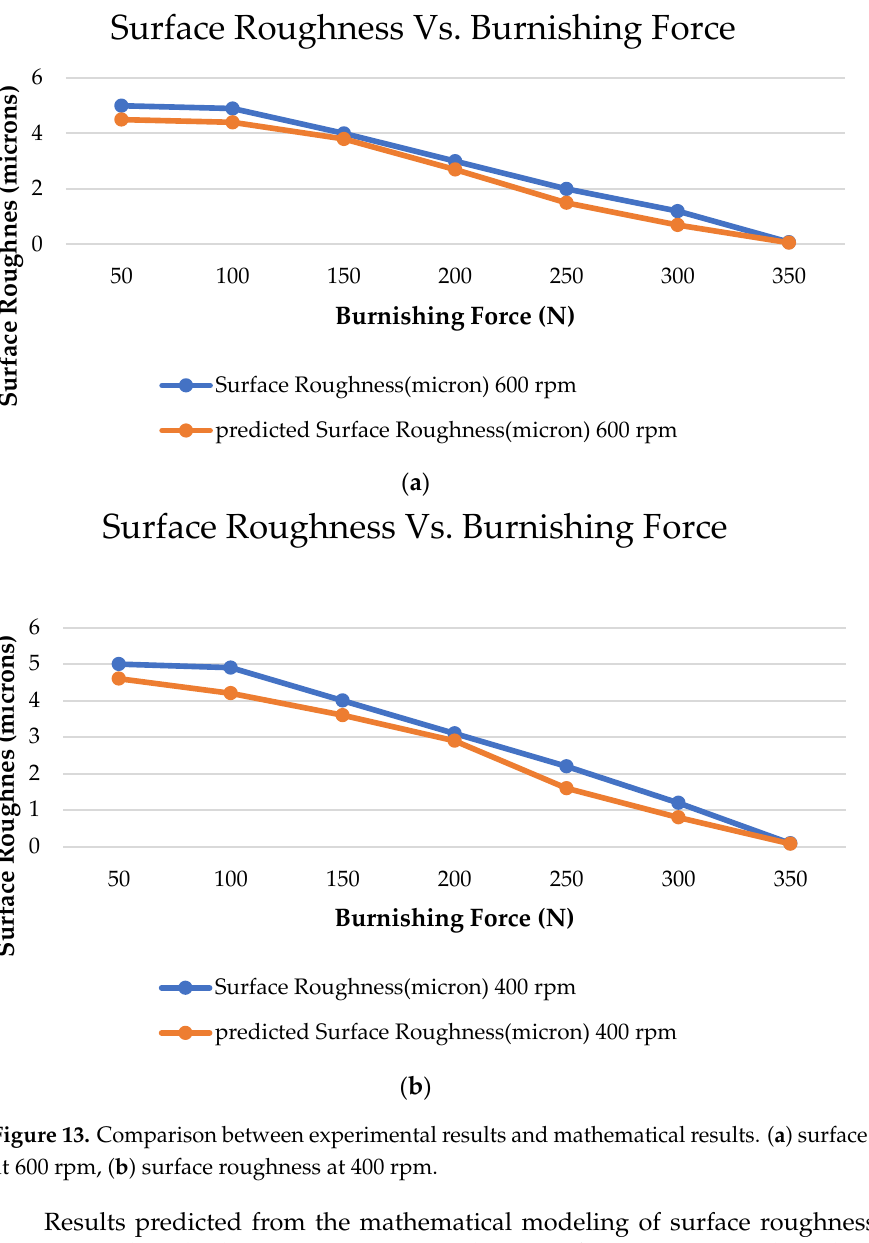
( d ) Figure 12. Differentiation of three − dimensional surface roughness, two − dimensional surface profile initially and after burnishing at 400 rpm: ( a ) 3D profile of initial surface, ( b ) 3D profile of burnished surface, ( c ) 2D profile of initial surface, ( d ) 2D profile of burnished surface. Further, Figure 13 shows the close agreement of the developed model with actual experiments. Results predicted from the mathematical modeling of surface roughness are at 1% deviation from experimental results at 600 rpm, as shown in Figure 13a. The main essential thing from the results for both the mathematical modeling and experimentation methods is that they follow an almost identical trend. Surface roughness from the experi- mental approach is 87 nanometers, which is larger than the results from the predicted mathematical modeling of 77 nanometers because of the machining challenges of Stavax. Apart from that, certainty is assumed while deriving mathematical models such as non- adhesive contact between surfaces. The surface is frictionless, and the workpiece is con- sidered elastoplastic, which is impossible while conducting experiments under these con- ditions. Results predicted from the mathematical modeling of surface roughness and the ex- perimental method at 400 rpm are at 1% deviation from experimental results, as shown in Figure 13b. The main essential result from mathematical modeling and experimentation is that they follow the same trend. Surface roughness from the experimental approach is 47 nanometers larger than the results from the predicted mathematical modeling of 35 nanometers. Figure 11a describes the initial three-dimensional surface profile compared with the